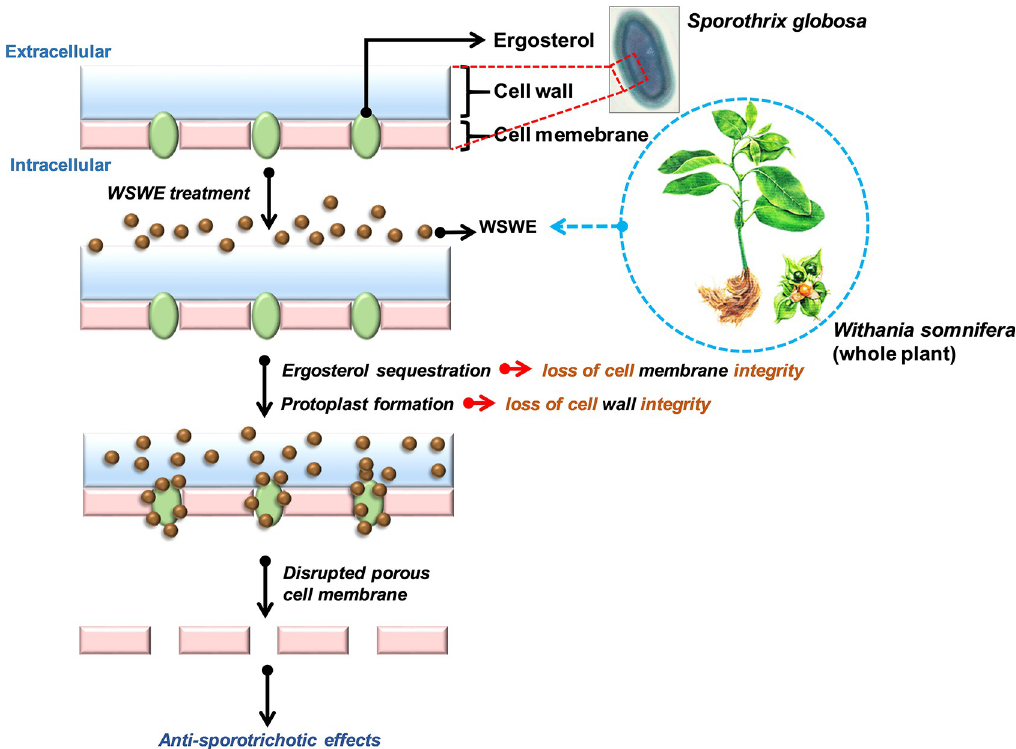
Fig 9. Proposed model of mode of action of WSWE as anti-fungal agent. A model depicting possible mode-of-action of WSWE as an anti-fungal agent. S . globosa cell wall and cell membrane disintegration is implicated in WSWE treatment, respectively, through protoplasting and ergosterol sequestration. Consequential pore formation and loss of intracellular content are speculated.